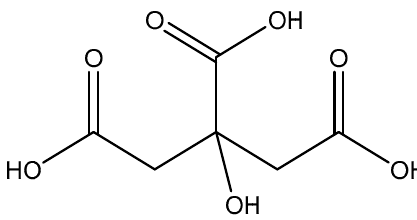
Figure 23. Illustrated structure of citric acid.